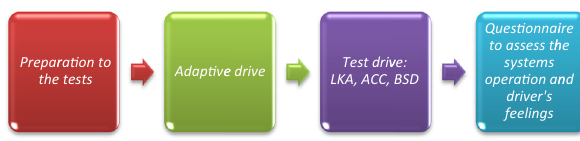
Figure 1: Diagram of the planned procedure to perform tests in tra ffi c. Source: author ’ s own